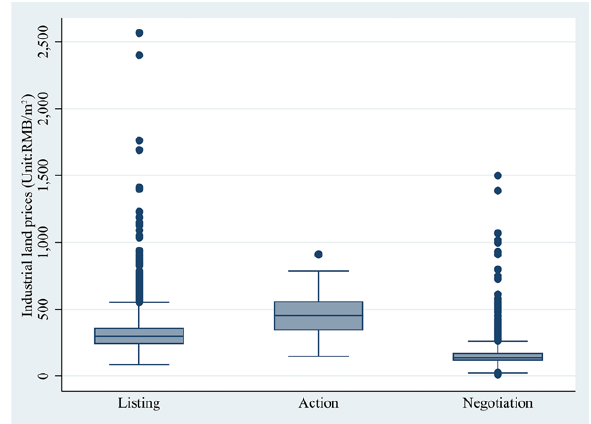
Figure 4. Comparisons of industrial land prices from 1999 to 2016 for land transferred via listing, auction, and negotiation